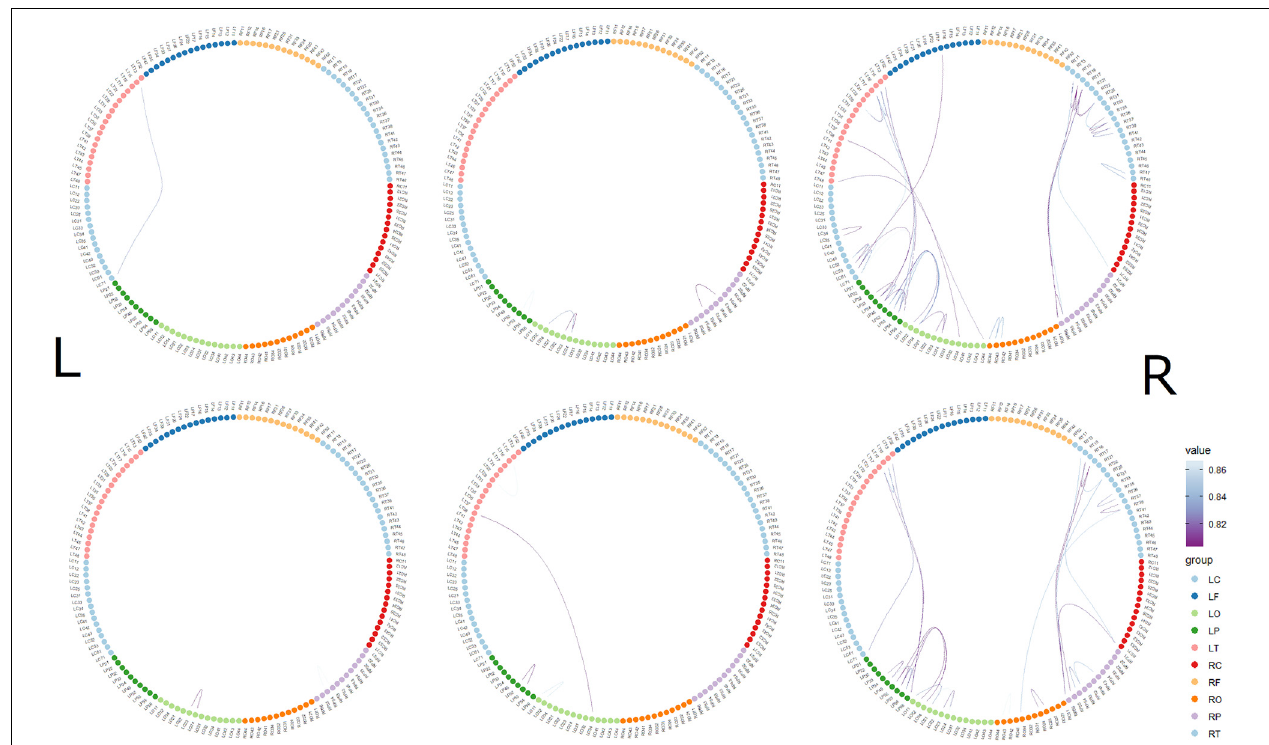
FIGURE 3 | Time-dependent changes in functional connections. The top row shows morally bad judgment conditions and bottom row shows morally good judgment conditions. The left column shows 62–140 ms, middle column shows 122–180 ms, and right column shows 182–304 ms. L indicates left hemisphere and R indicates right hemisphere. MEG channels are placed on RF (right frontal area), RT (right temporal area), RC (right central area), RP (right parietal area), RO (right occipital area), LO (left occipital area), LP (left parietal area), LC (left central area), LT (left temporal area), and LF (left frontal area). The value denotes the correlation coefficient r.